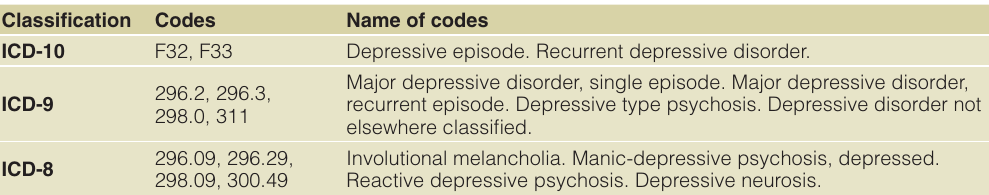
Table 2. Definition of outcome according to ICD-10, ICD-9 and